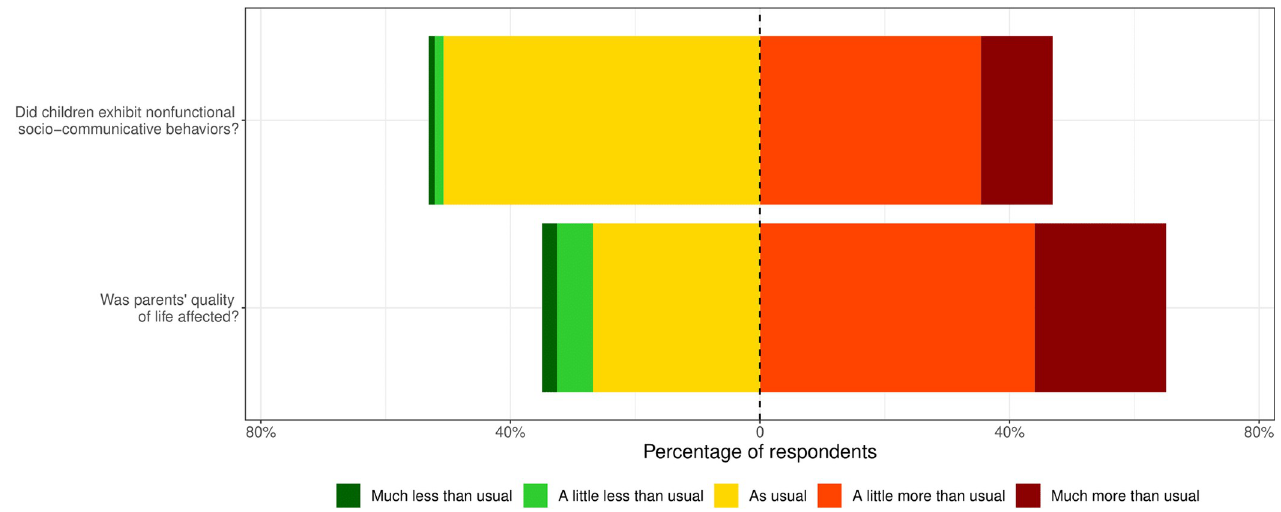
Fig 1. Distribution of the median responses on the nonfunctional socio-communicative behaviors and quality of life Likert scales.